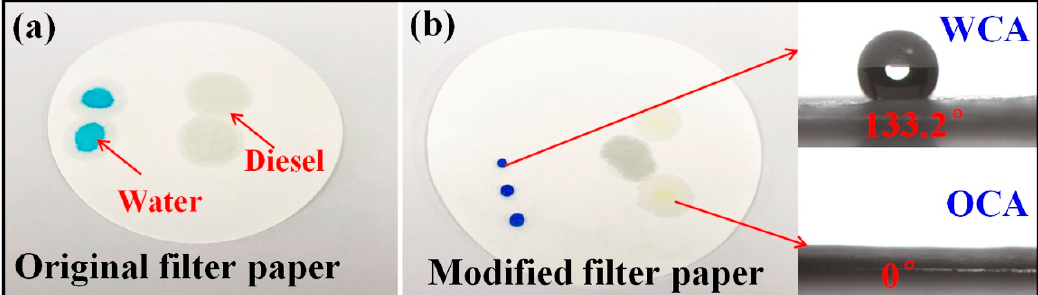
Figure 10. Photographs of ( a ) water droplets with methylene blue as the dye and diesel on filter paper surface before modification; ( b ) water droplets and diesel on filter paper surface after modification.